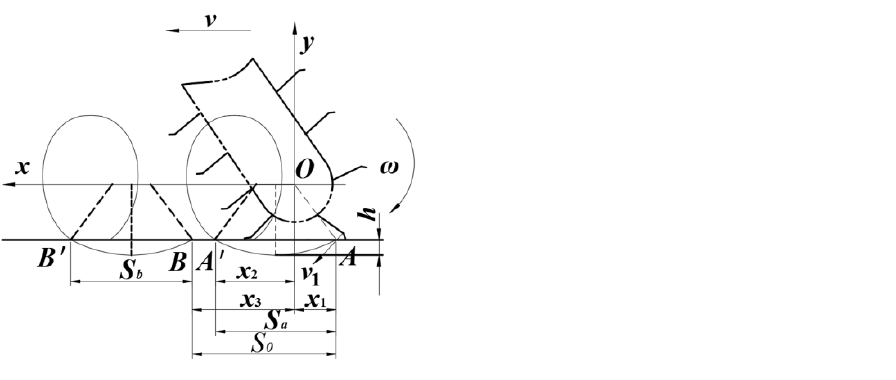
Figure 9. The motion track of two adjacent film ‐ picking hook teeth on the conveying chain rake.